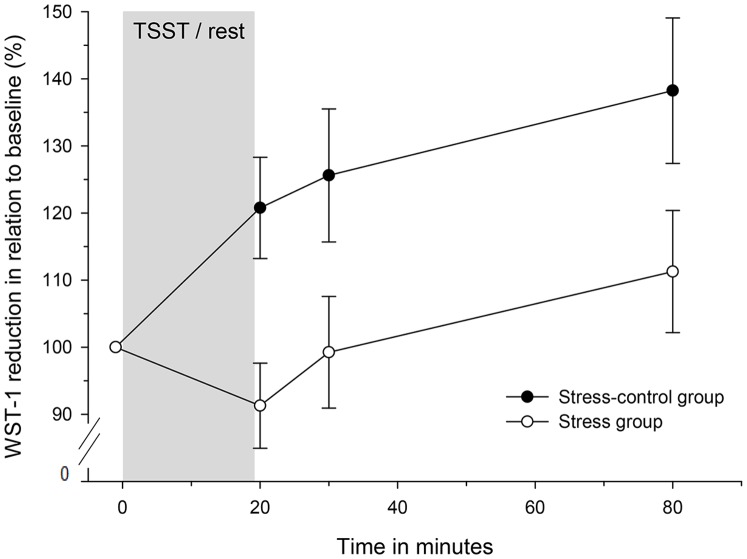
Course of WST-1 reduction over time in the stress and stress-control group.Values are given as means ± SEM.